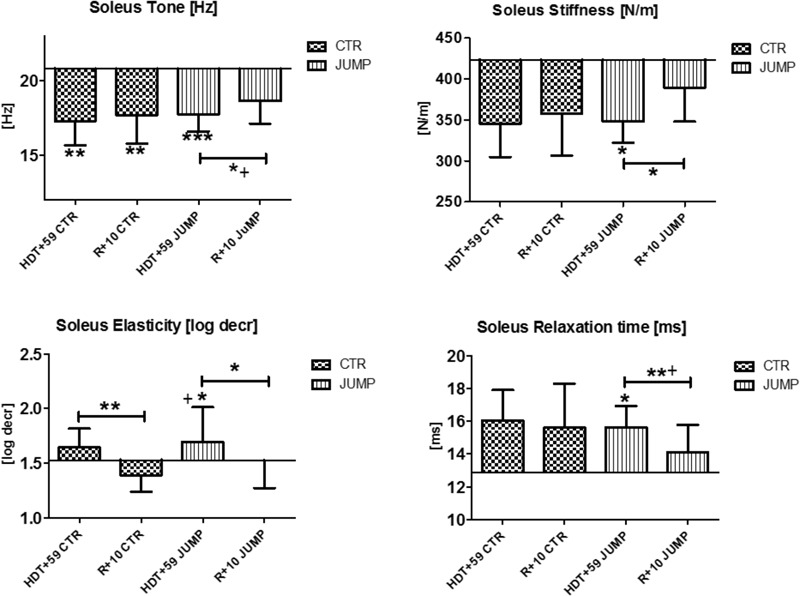
Soleus (MP17/18). Oscillation signal patterns in RSL bed rest study. ABD = average baseline data (Tone HDT+1 = 20.77; Stiffness HDT+1 = 423.33; Elasticity HDT+1 = 1.53; Relaxation HDT+1 = 12.89). ∗p < 0.05, ∗∗p < 0.01, ∗∗∗p < 0.001 ± SD, +Spearman ρ.